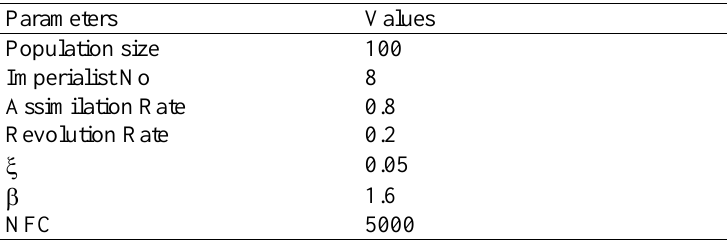
Table 6. Parameters setting for